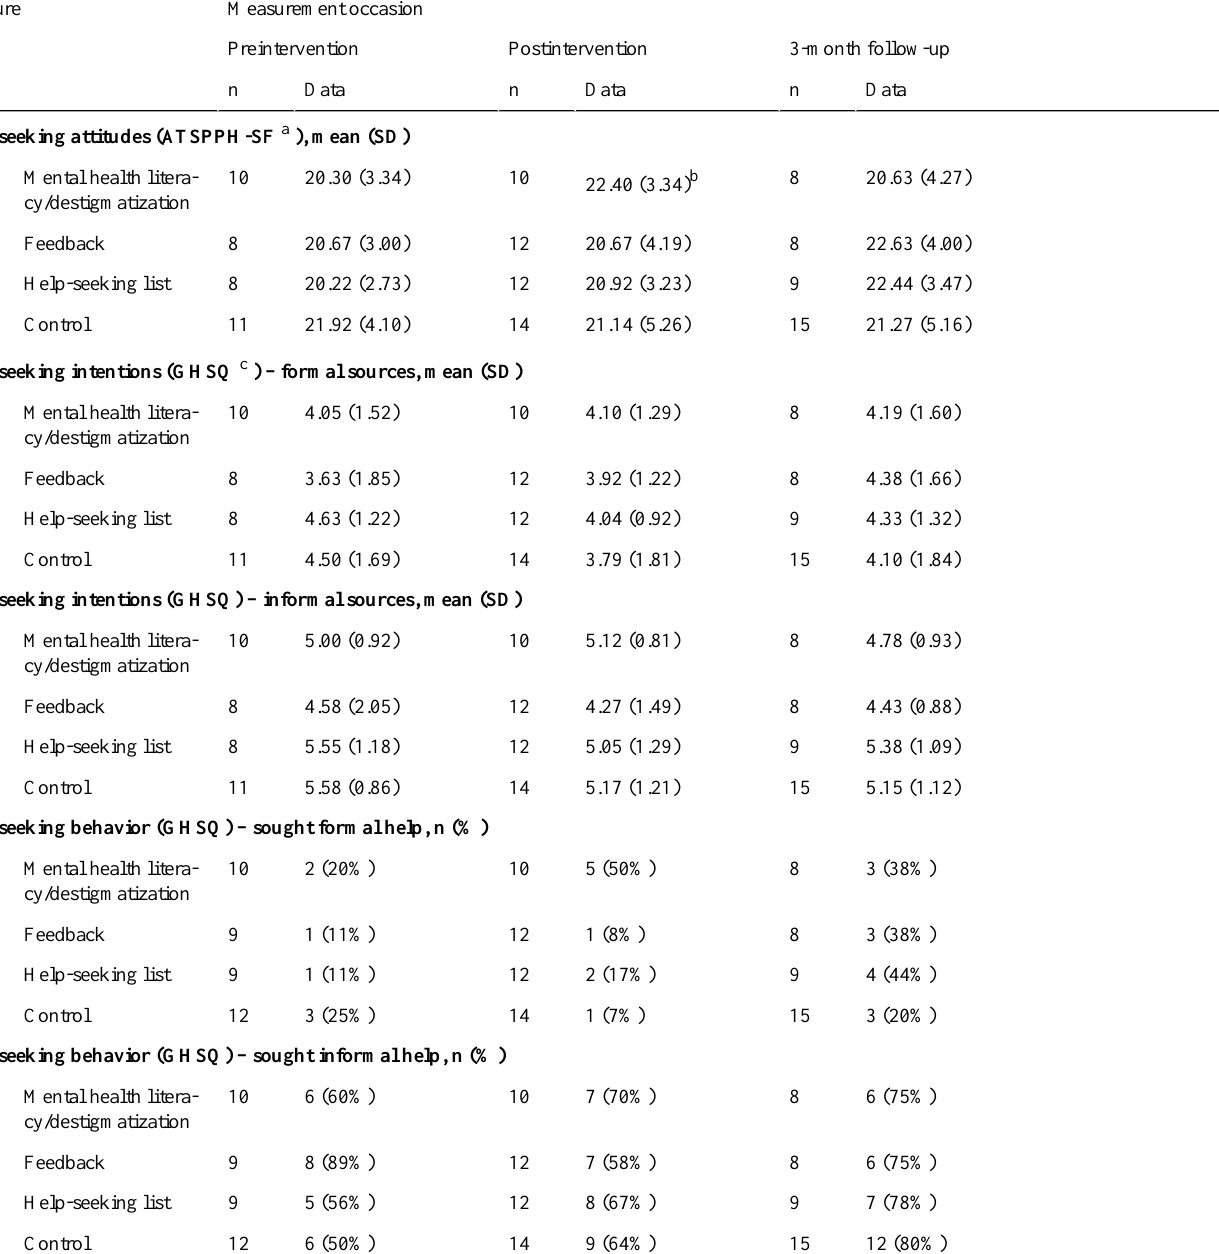
Table 3. Observed means, standard deviations, and proportions for the primary outcome measures at each measurement occasion for the trial conditions. Measurement occasionMeasure